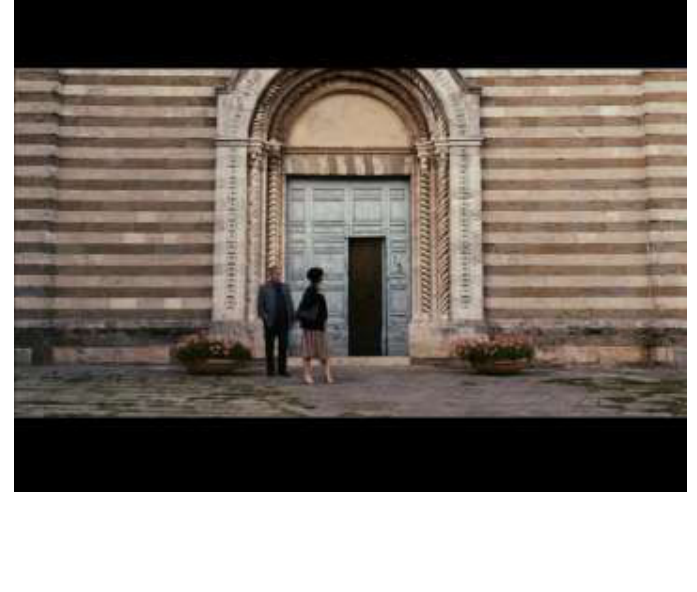
Figure 7: Literally tunneled in by their environment, Elle and James, visibly unhappy with each other, retreat into their own